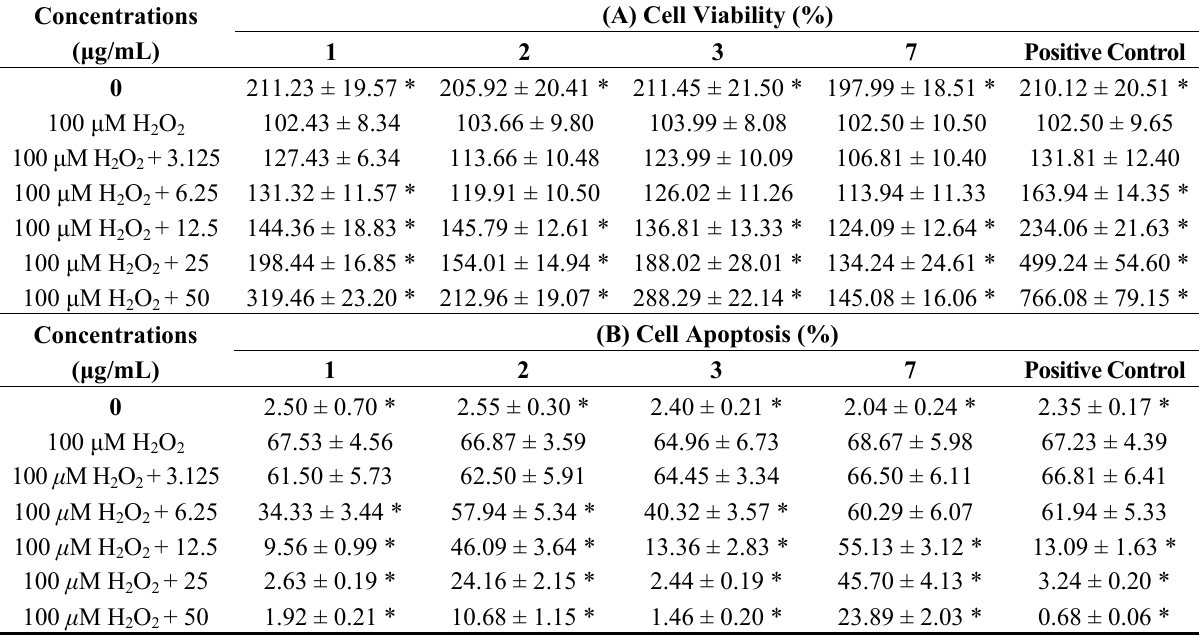
Table 2. Protective effects of the phenolics 1 – 3 , 7 on H osteoblastic cells. Rat osteoblast cells were cultured in the presence of 100 μ M H without treatment of the phenolics 1 – 3 , 7 different concentrations. ( A ) The cell viability,